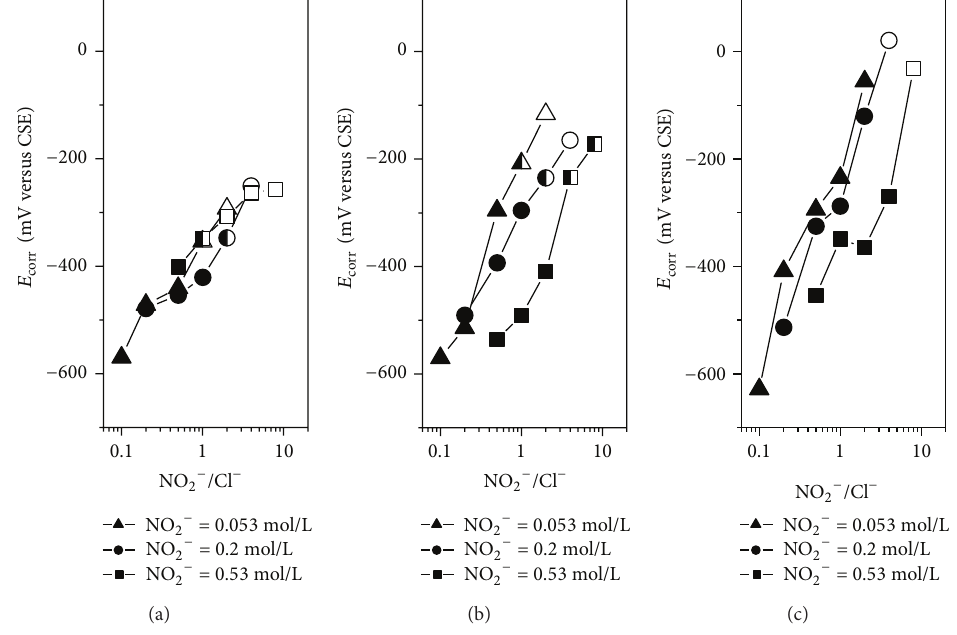
Figure 6: Effect of NO 2− on 𝐸 versus log(NO 2− /Cl − ) curves. (a) pH = 12.6, (b) pH = 10.3, and (c) pH = 8.1. corr 3.4. Relationship between 𝐸 and NO 2 − /SO 4 2− . The on the curve of 𝐸 corr